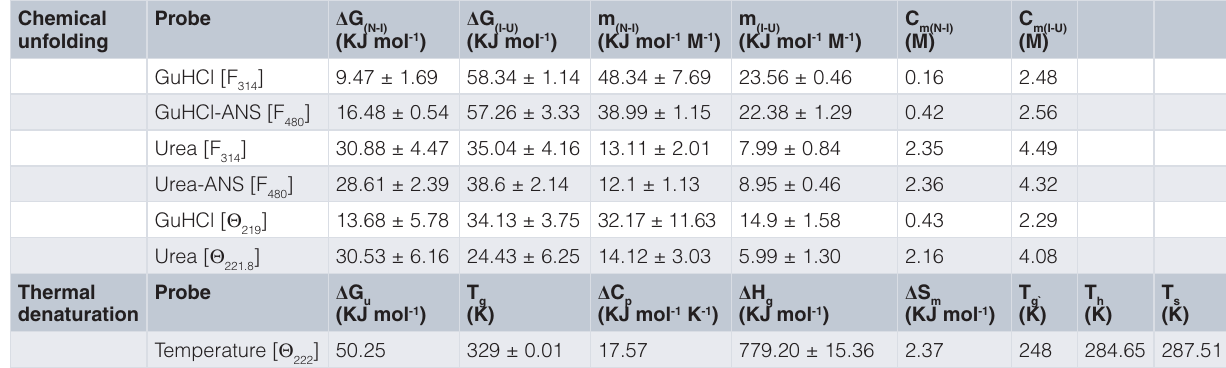
Table 1. Thermodynamic parameters derived from equilibrium unfolding transitions of hAR during thermal denaturation and Chemical induced unfolding studies using different probes. Chemical